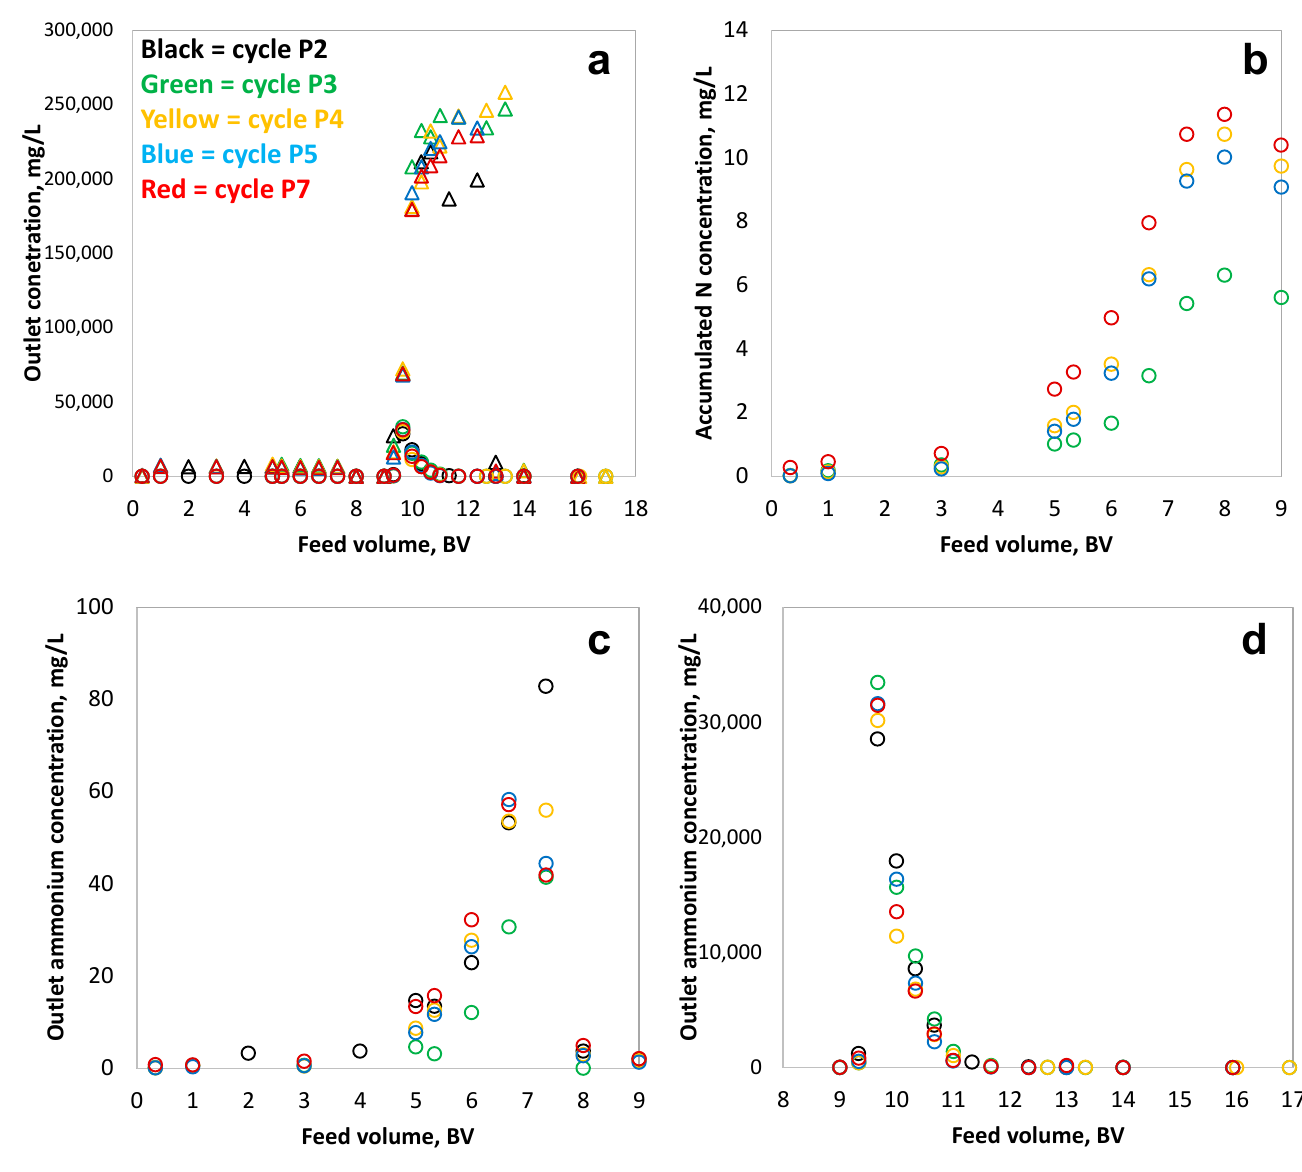
Figure 5. ( a ) Cyclic separation profiles of cycles 2, 3, 4, 5, and 7 in pilot-scale stability tests, ( b ) accumulated nitrogen concentration in the effluent, ( c ) the ammonium profiles of loading, ( d ) the ammonium profiles of regeneration (e.g., P2 = cycle 2 in pilot tests, CS16GC in K + form, V bed = 6.54 L, Q = 4 BV/h at 60 °C. Details of loading, washing, and regeneration steps are given in Section 2.2.2 in the text.)). Triangles: K + ; circles: NH 4+ .